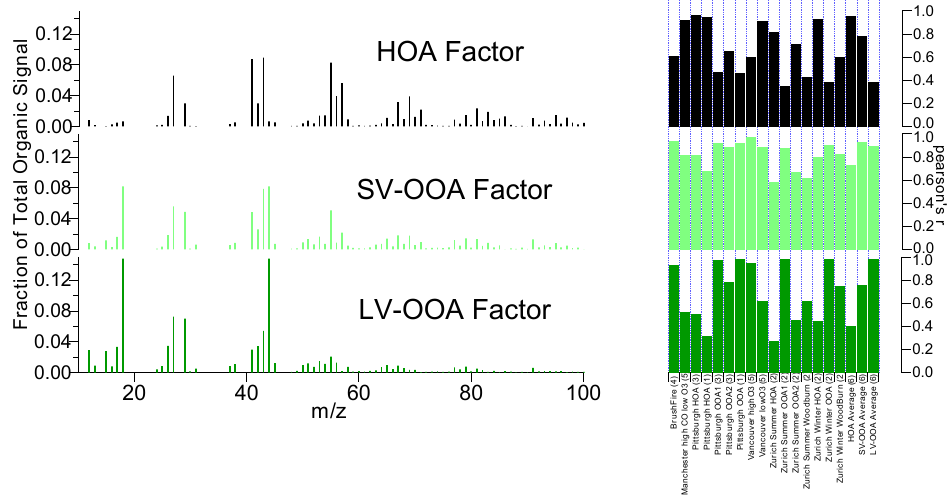
Fig. 6. Mass spectra for the three factors identified in PMF analysis (HOA, SV-OOA, and LV-OOA; left) and Pearson’s R correlations of those solution mass spectra with previously reported mass spectra (1, 2, 3, 4, 5, 6: Zhang et al., 2005; Lanz et al., 2007; Ulbrich et al., 2009; Bahreini et al., 2005; Alfarra et al., 2004; Ng et al., 2011, respectively).